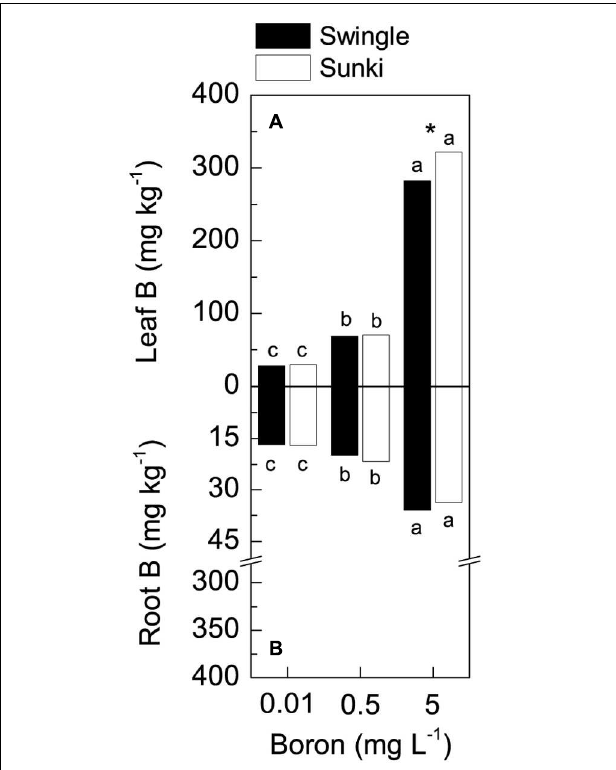
FIGURE 2 | Leaf (A) and root (B) boron concentration in sweet orange trees grafted on Swingle or Sunki rootstocks grown in nutrient solution with varying concentrations of boron for 130 days. Asterisks compare rootstocks in a given boron concentration, whereas lowercase letters indicate significant difference between boron concentrations in a given rootstock (Tukey test at p <